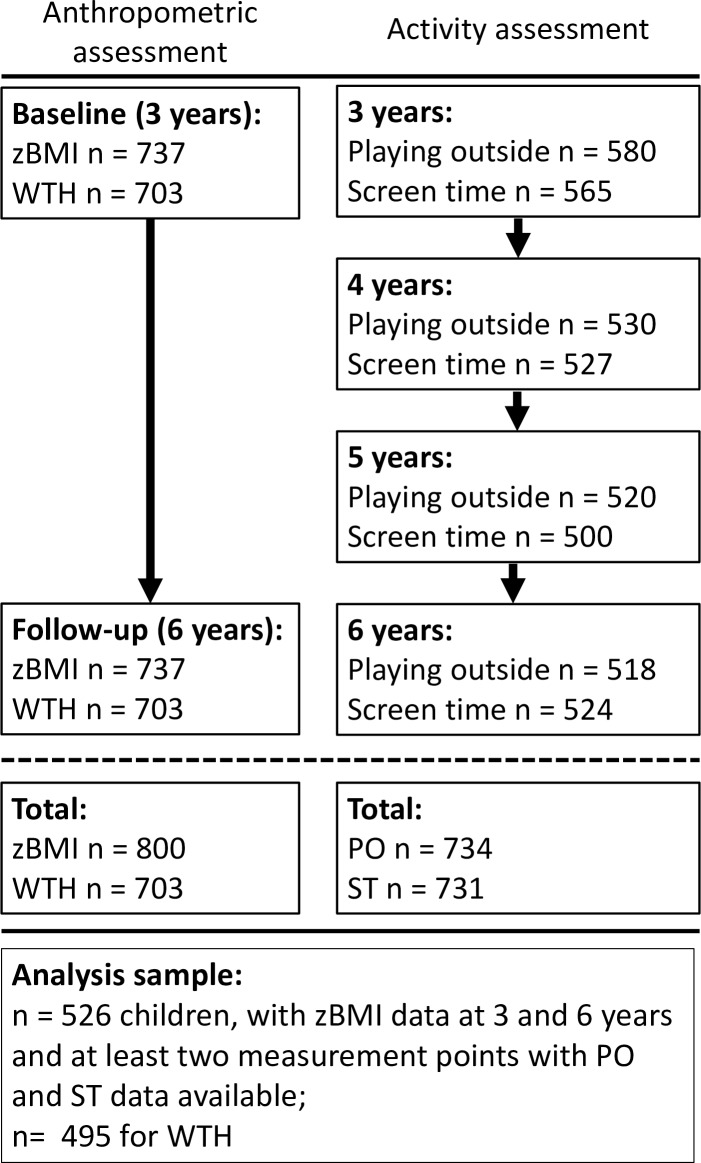
Flow chart of study participation.Abbreviations: zBMI BMI z-scores according to WHO reference population, WTH waist-to-height ratio.